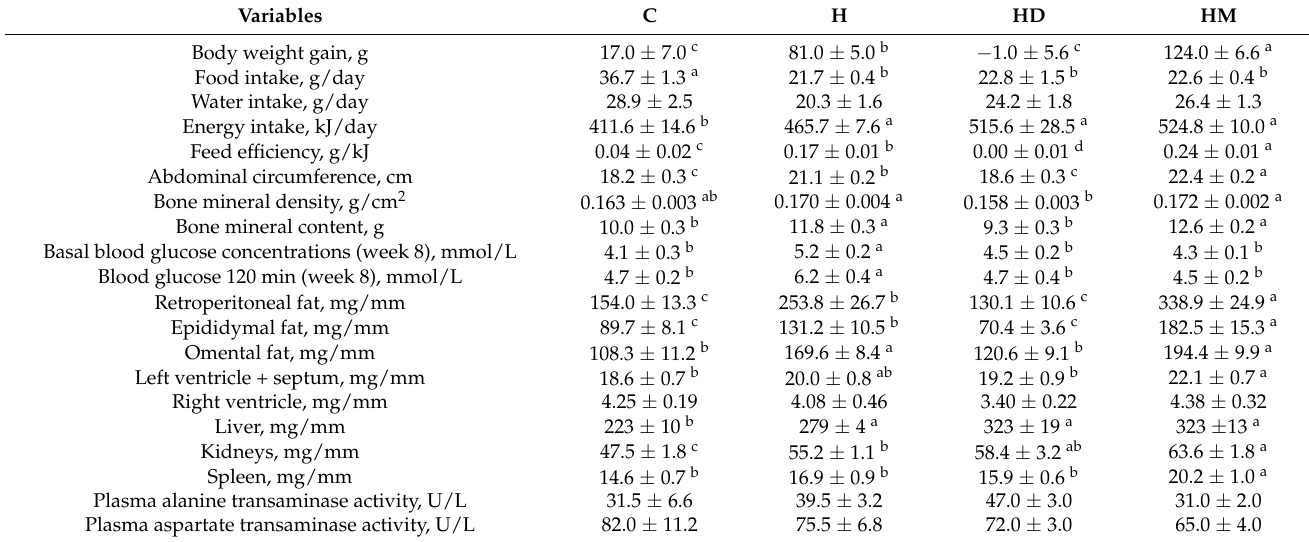
Table 2. Effects of macroalgae on metabolic, tissue and biochemical variables.